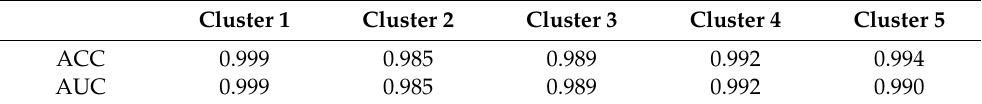
Table 10. The predictive results of random forest using the test